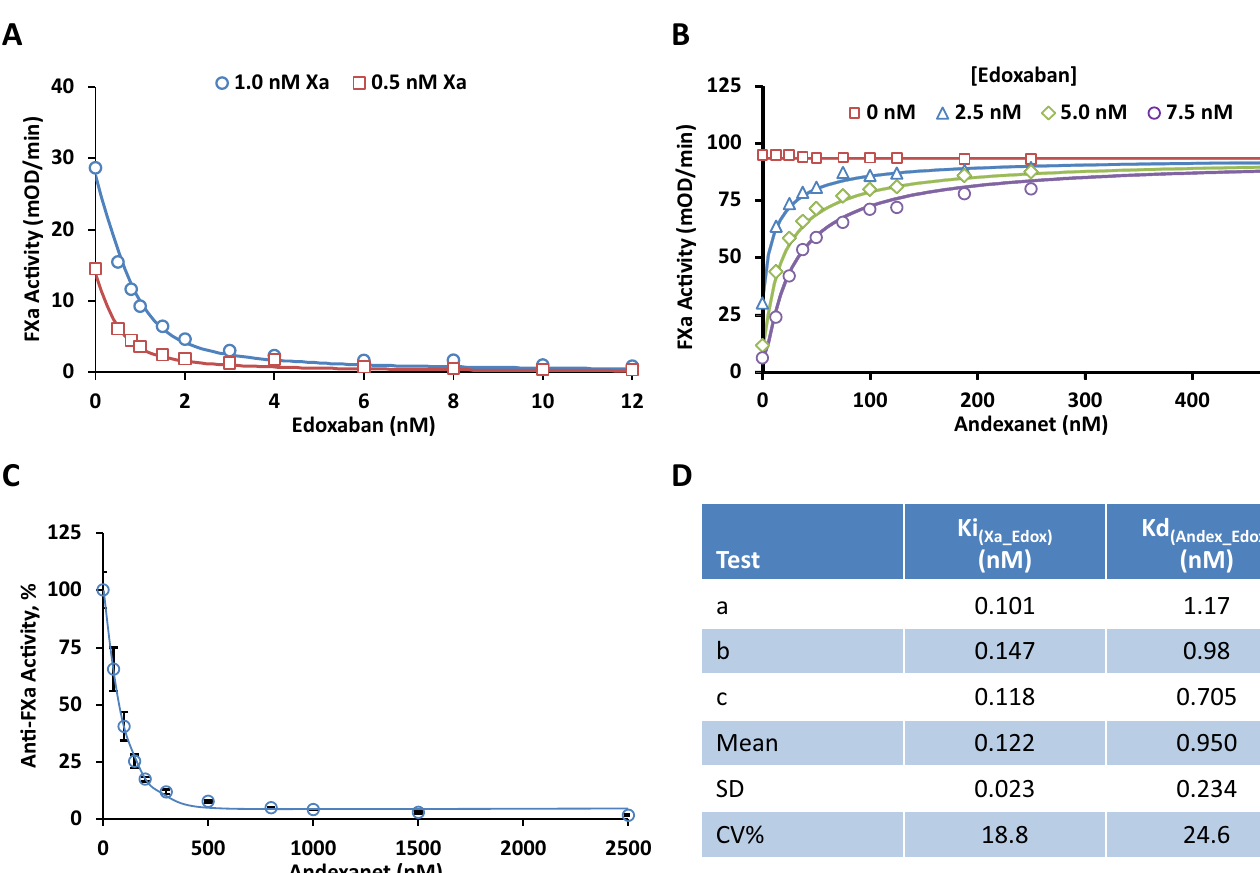
Fig 2. Edoxaban anti-FXa activity and andexanet effects in vitro . (A) Inhibition of FXa chromogenic activity by edoxaban in a buffer system with purified enzyme. Human FXa at 0.5 nM ( □ ) and 1.0 nM ( (cid:14) ) were pre-incubated with increasing concentrations of edoxaban (0, 0.5, 0.8, 1, 1.5, 2, 3, 4, 6, 8, 10, 12 nM) at RT for 2 hrs. Residual FXa activity was determined by measuring the initial rates of peptidyl substrate hydrolysis (mOD 405 /min) at RT over 5 min. The initial velocity was fitted with Dynafit to obtain the kinetic parameters Ki and kcat using the pre-determined Km (82.2 μ M) as described in Materials and Methods. Fig 2A shows a representative result from one of the three experiments shown in Fig 2D (Test a for Ki). The symbols represent the measured mean initial rate from quadruplicate wells at each edoxaban concentration. The solid lines were drawn using the best fitted values with Ki = 0.101 nM, kcat = 156 1/s. (B) Reversal of edoxaban-induced inhibition of FXa chromogenic activity by andexanet in a buffer system with purified enzyme. Human FXa (3.0 nM); different concentrations of edoxaban at 0 ( □ ), 2.5 ( 4 ), 5.0 ( (cid:5) ),and 7.5 nM ( (cid:14) ); and increasing concentrations of andexanet (0, 12.5, 25, 37.5, 50, 75, 100, 125, 188, 250, 500 nM) were pre-incubated at RT for 2 hrs. Residual FXa activity was determined by measuring the initial rates of peptidyl substrate hydrolysis (mOD 405 /min) at RT over 5 min. The initial velocity was fitted with Dynafit to obtain the kinetic parameters Kd and kcat using the pre-determined Km (82.2 μ M) and Ki (0.122 nM) as described in Materials and Methods. Fig 2B shows a representative result from one of the three experiments shown in Fig 2D (Test b for Kd). The symbols represent the measured mean initial rate from duplicate wells at each andexanet concentration. The solid lines were drawn using the best fitted values with Kd = 0.98 nM, kcat = 176 1/s. (C) Reversal of edoxaban-induced anti-FXa activity by andexanet in human plasma. Edoxaban (76 ng/mL, 0.136 μM) and increasing concentrations of andexanet (0, 0.05, 0.1, 0.15, 0.2, 0.3, 0.5, 0.8, 1, 1.5, 2.5 μM) were prepared in human plasma and pre-incubated at RT for 30 min. Residual anti-FXa activity for edoxaban was measured as described in Materials and Methods. Fig 2C shows edoxaban anti-FXa activity (%) after normalization of the results to the mean anti-FXa value at 0 nM andexanet. Data were plotted as the mean ± standard deviation from three separate experiments. (D) Constants for edoxaban interaction with FXa (Ki) and andexanet (Kd) determined by the kinetic measurements as described in panel (A) and panel (B),